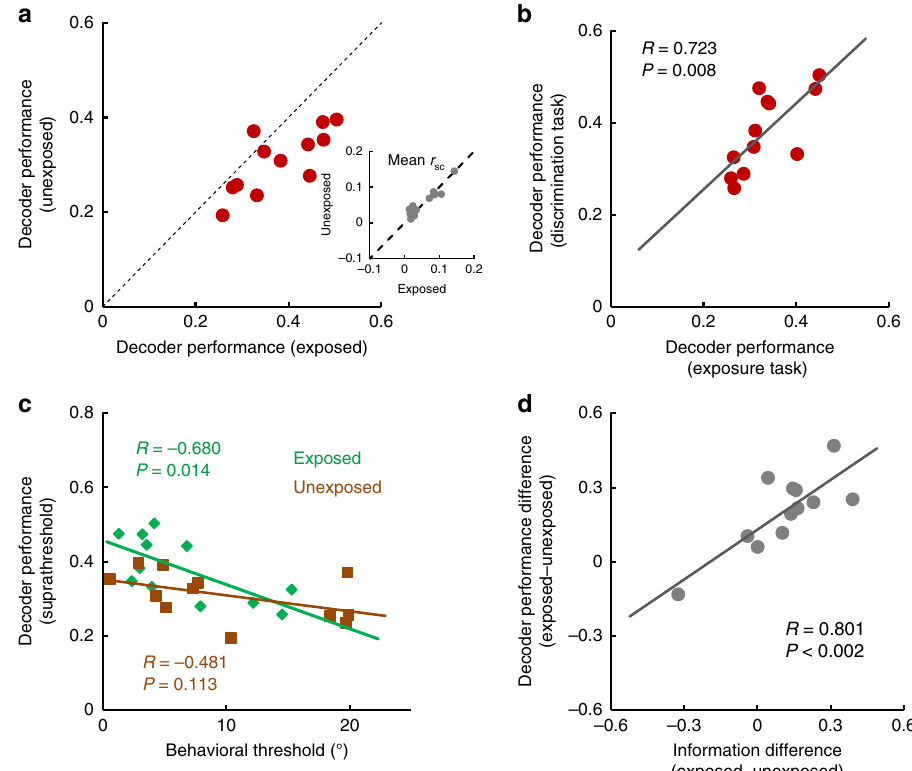
Fig. 4 Neuronal populations extract more sensory information after subthreshold stimulus exposure. a The decoder performance of a linear classi fi er during the discrimination task is greater for the previously exposed images than for the unexposed images across recording sessions ( n = 12, P = 0.0034, Wilcoxon sign-rank test). Mean fi ring rates from 90% of trials (sampled 50,000 times) were used as a training set; the performance of the classi fi er was calculated for the remaining set of trials. Inset shows the mean noise correlations ( r sc ) averaged across all the pairs in the recording session ( n = 12, P = 0.840, Wilcoxon sign-rank test). b , Decoder performance during the 18-frame image presentation (300 ms images, discrimination task) is correlated with decoder performance during the two-frame image presentation (34 ms, exposure task) ( R = 0.723, P = 0.008, Pearson correlation). c Decoder performance during the discrimination task (300-ms images) is strongly correlated with behavioral performance for exposed images ( R = 0.680, P = 0.014, Pearson correlation) but not for unexposed images ( R = 0.481, P = 0.113, Pearson correlation). d Across sessions, the increase in decoder performance ( Δ P = ( P exposed − P unexposed )/( P exposed + P unexposed )) after exposure is highly correlated with the change in mutual information ( I exposed – I unexposed )/( I exposed + I unexposed ) (relative change in the session-averaged mutual information of individual neurons; R = 0.801, P = 0.0017, Pearson